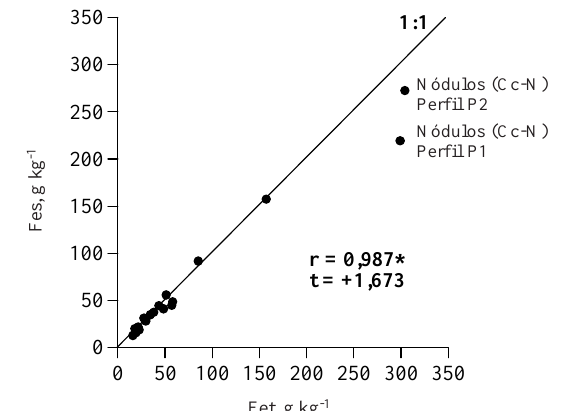
Figura 1. Relação entre os teores de ferro obtidos por ataque sulfúrico (Fe ) e fluorescência de s raios-X (Fe ). A reta corresponde a uma t inclinação de 45 °, passando pela